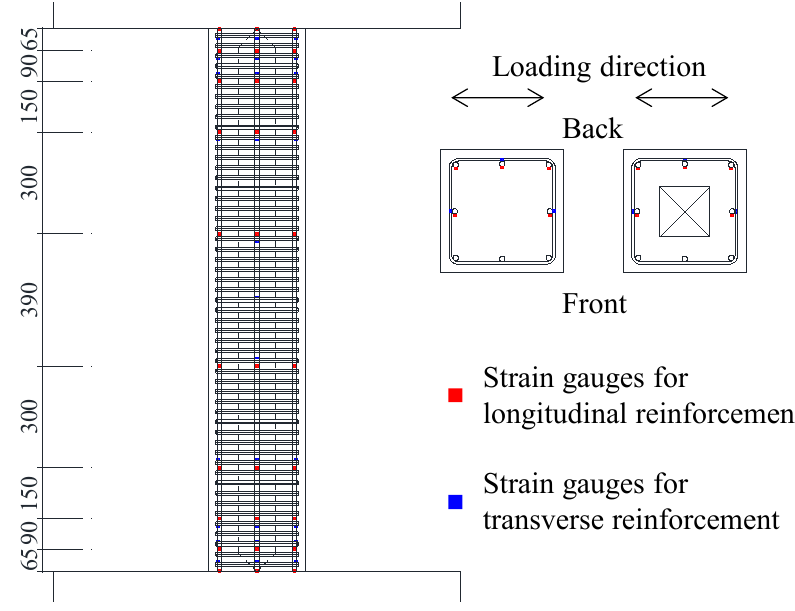
Figure 5. Strain gauges on longitudinal and transverse reinforcement.